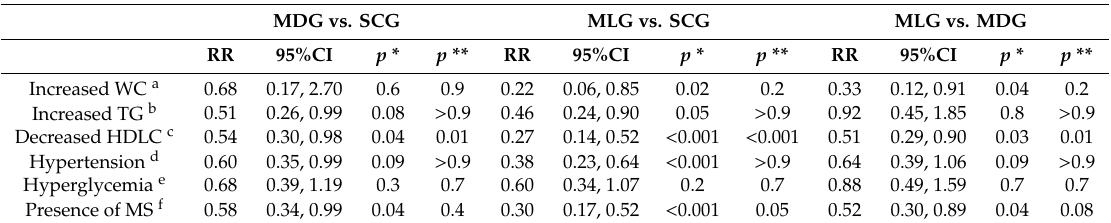
Table 3. Between-group di ff erences in the presence of the metabolic syndrome and its components according to intention to treat analysis ( n =